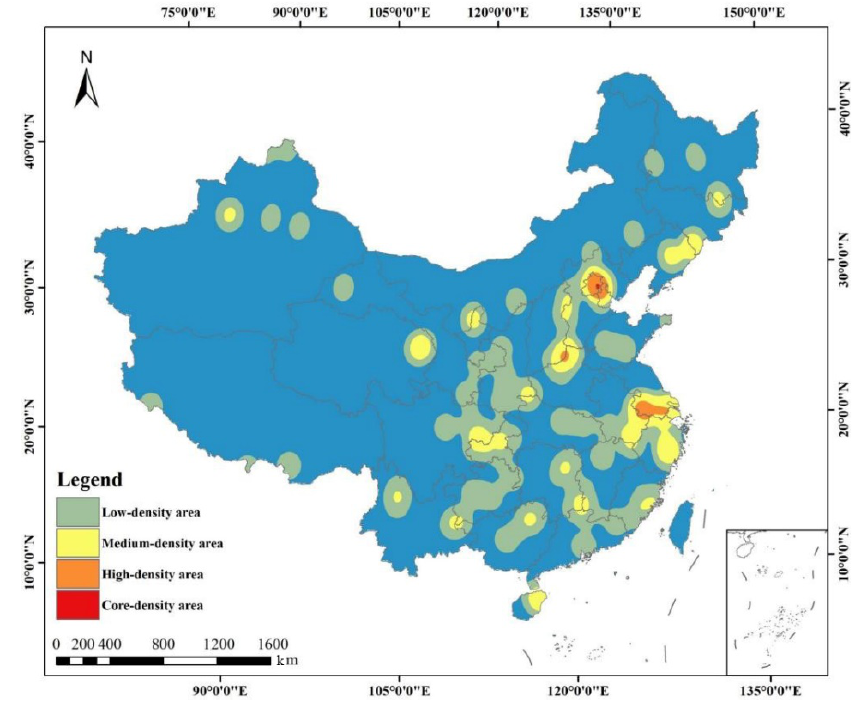
Figure 4. Spatial kernel density distribution of the NRTTC.